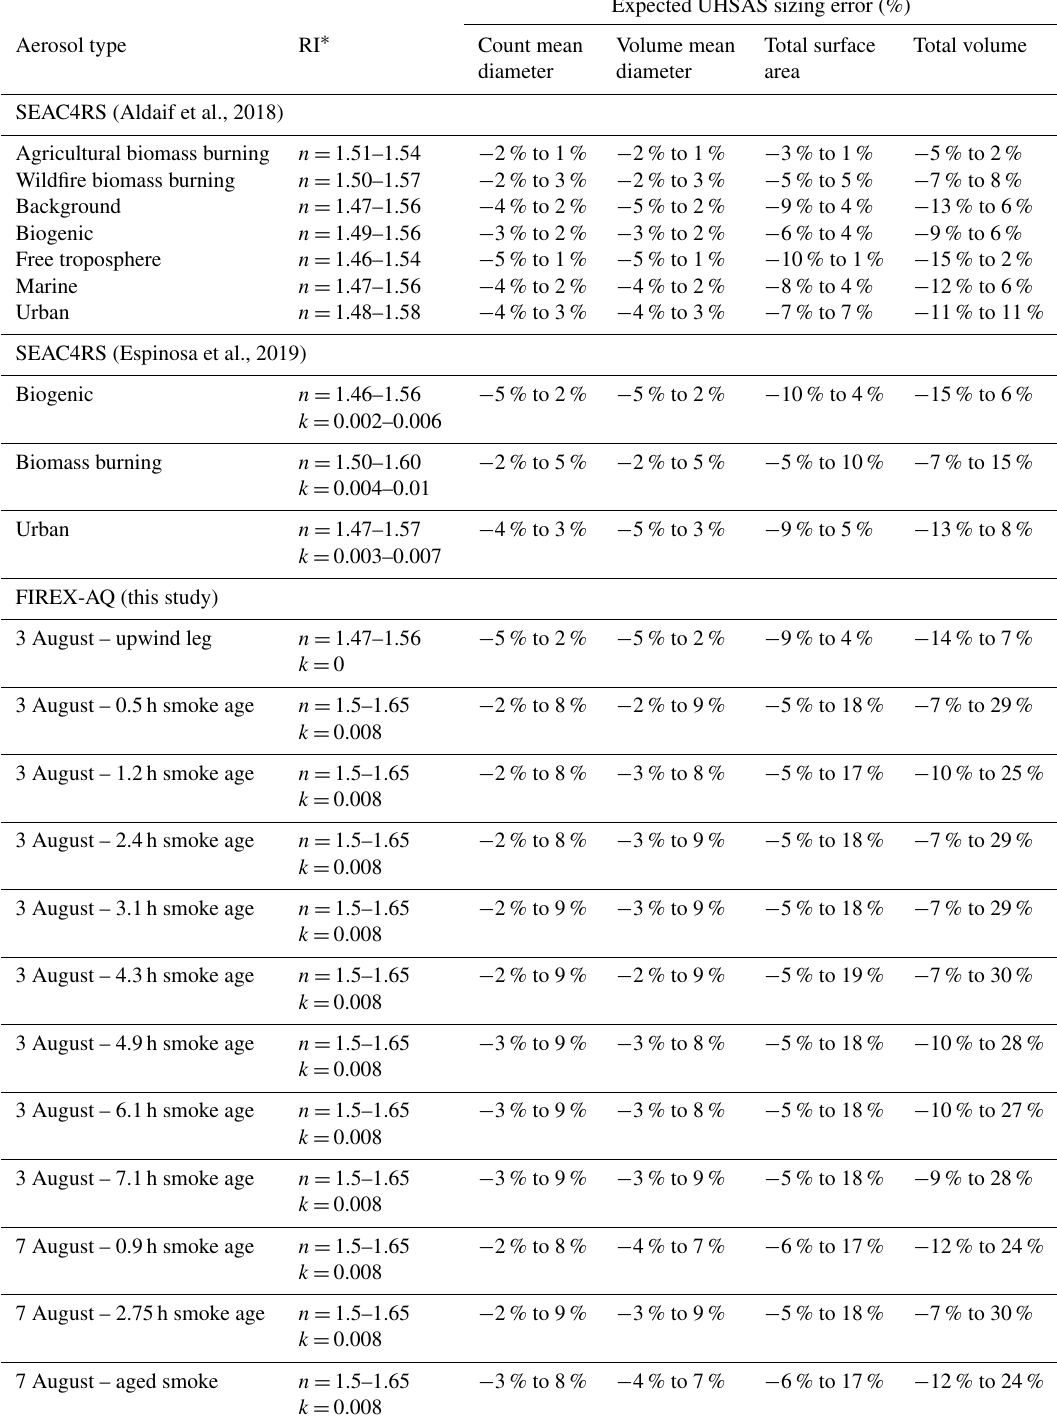
Table 5. Expected percent UHSAS sizing error associated with an atmospherically relevant range of refractive indices (RIs) computed for characteristic size distributions by linearly interpolating between the laboratory response curves of NaF, (NH 4 ) 2 SO 4 , NaCl, and SRFA, as shown in Figs. 5 and 6. Size distributions for SEAC4RS are from Shingler et al. (2016), while FIREX-AQ size distributions are those shown for the LAS in Figs. 10 and